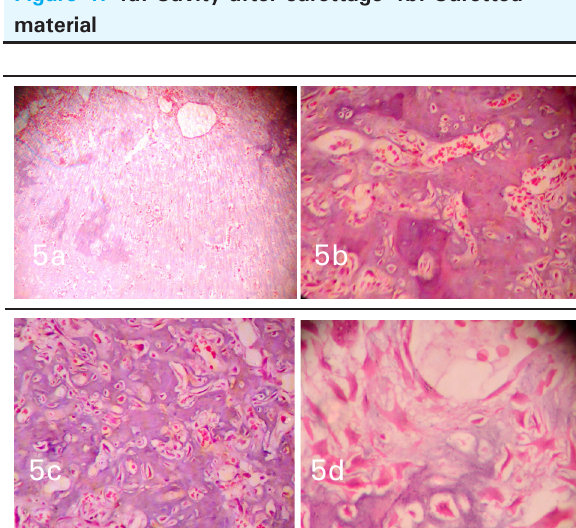
figure 5. 5a. histopathology (H and e stainX 40 )